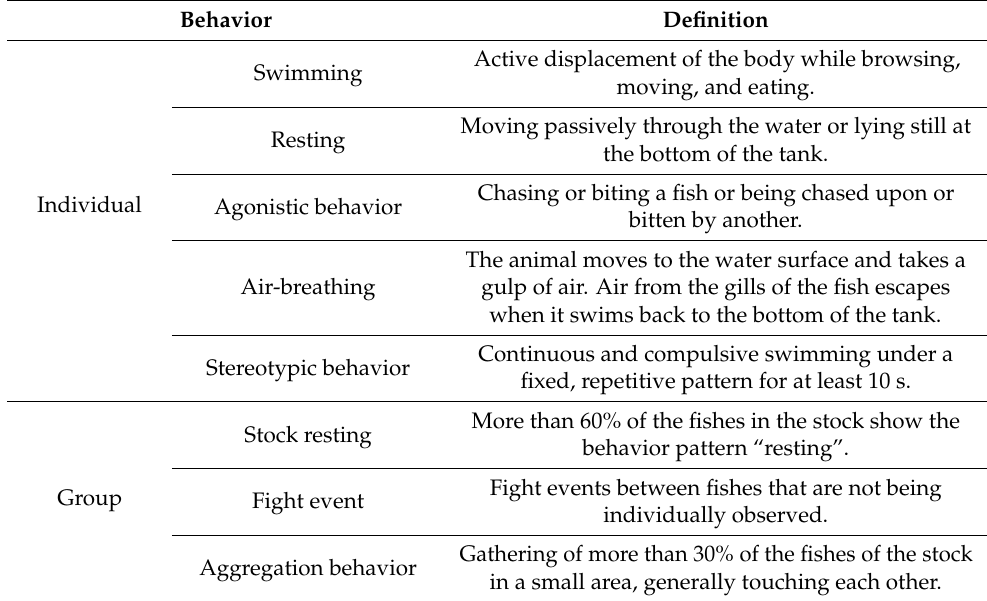
Table 6. Ethogram—behavioral patterns and their definition, adapted from